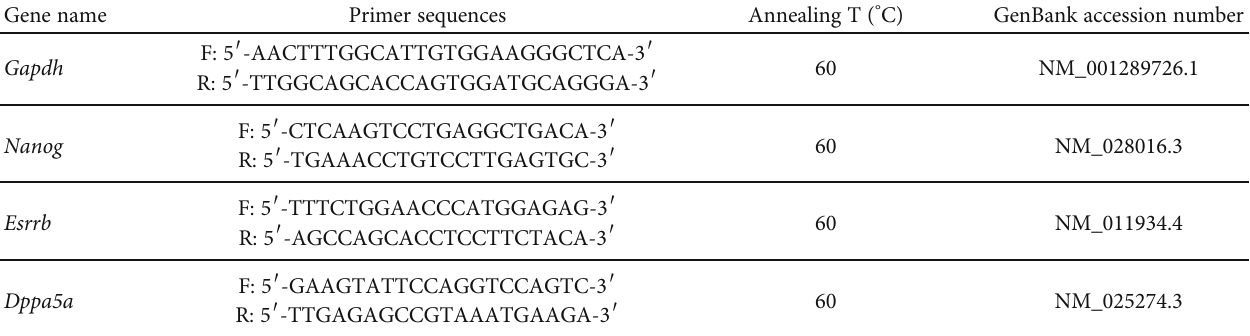
Table 1: Details of primers used for the qRT-PCR analysis of selected genes used in the PCR